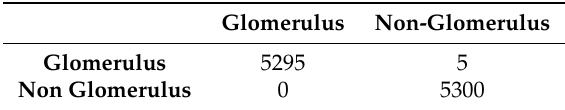
Table 4. Testing confusion matrix for pre-trained